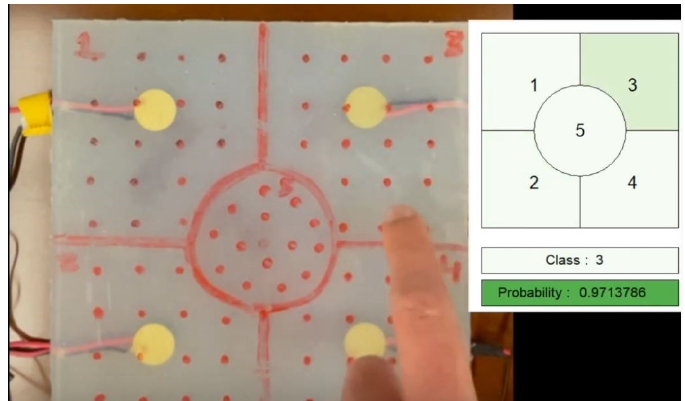
Figure 4. Real ‐ time classification of the prototype. Figure 4. Real-time classification of the